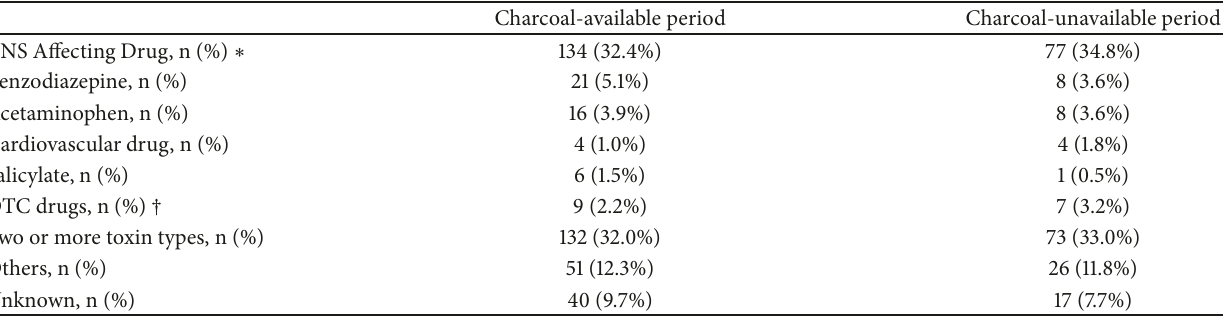
Table 2: Toxic substances ingested by